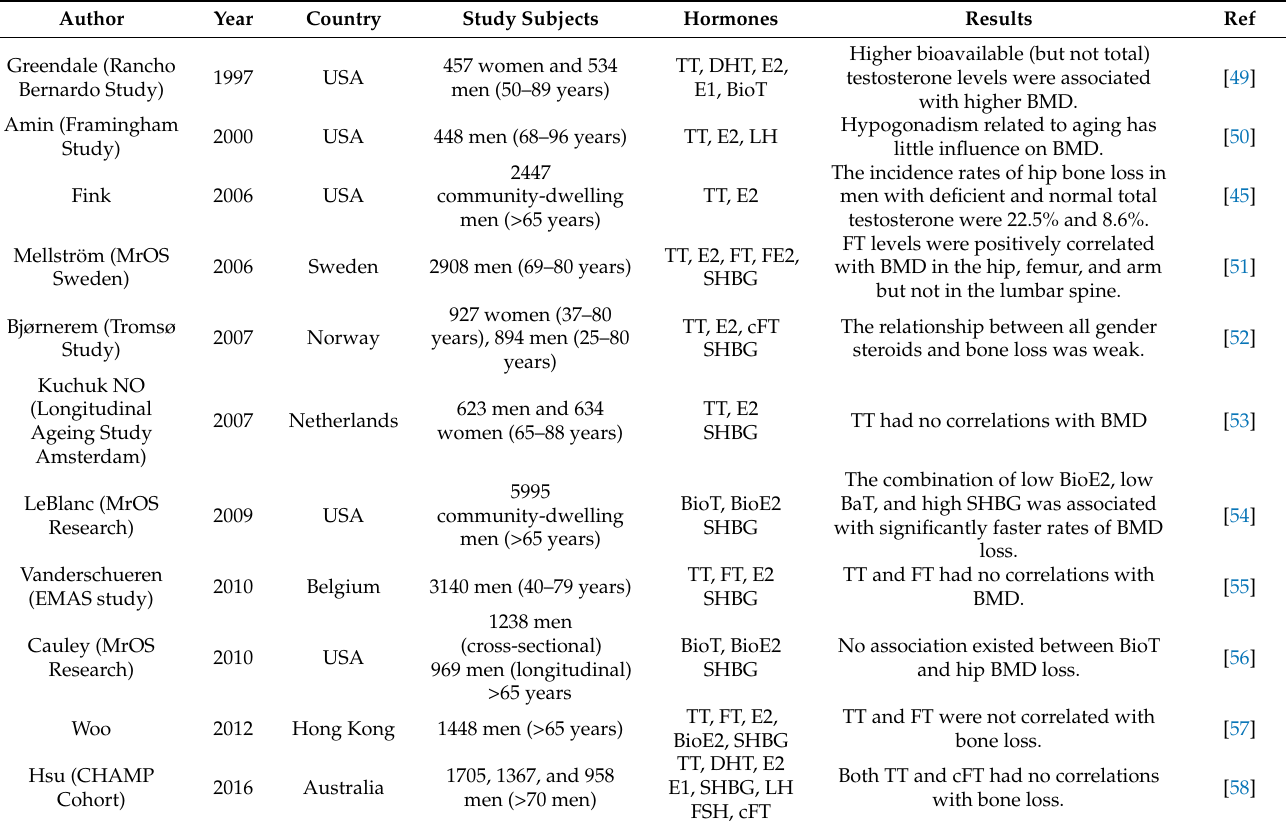
Table 2. The relationship between testosterone and BMD in